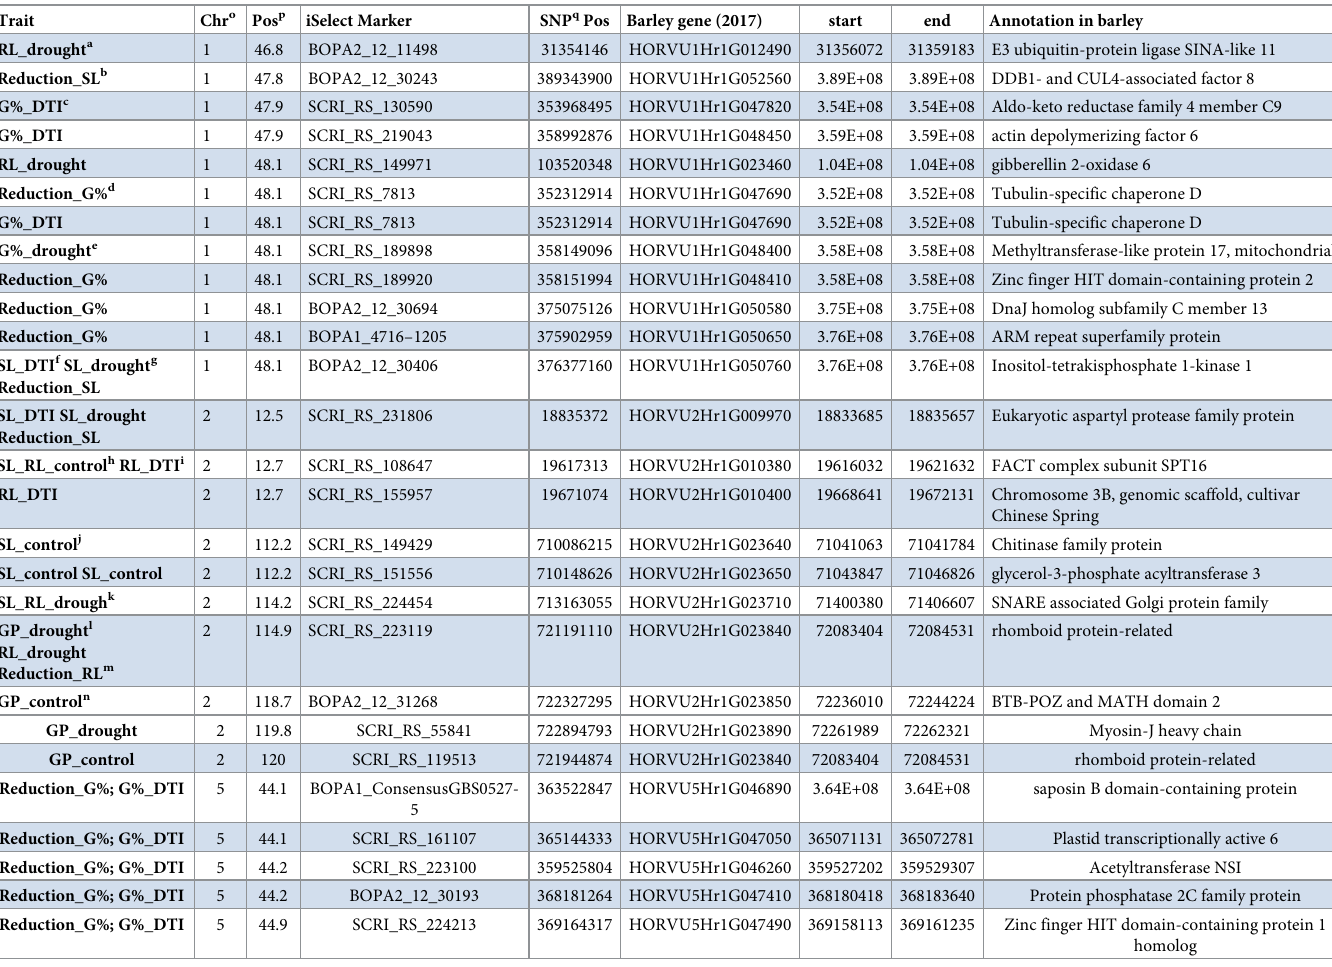
Table 3. The functional annotation of the putative candidate genes associated with the estimated traits under drought and control growth conditions.